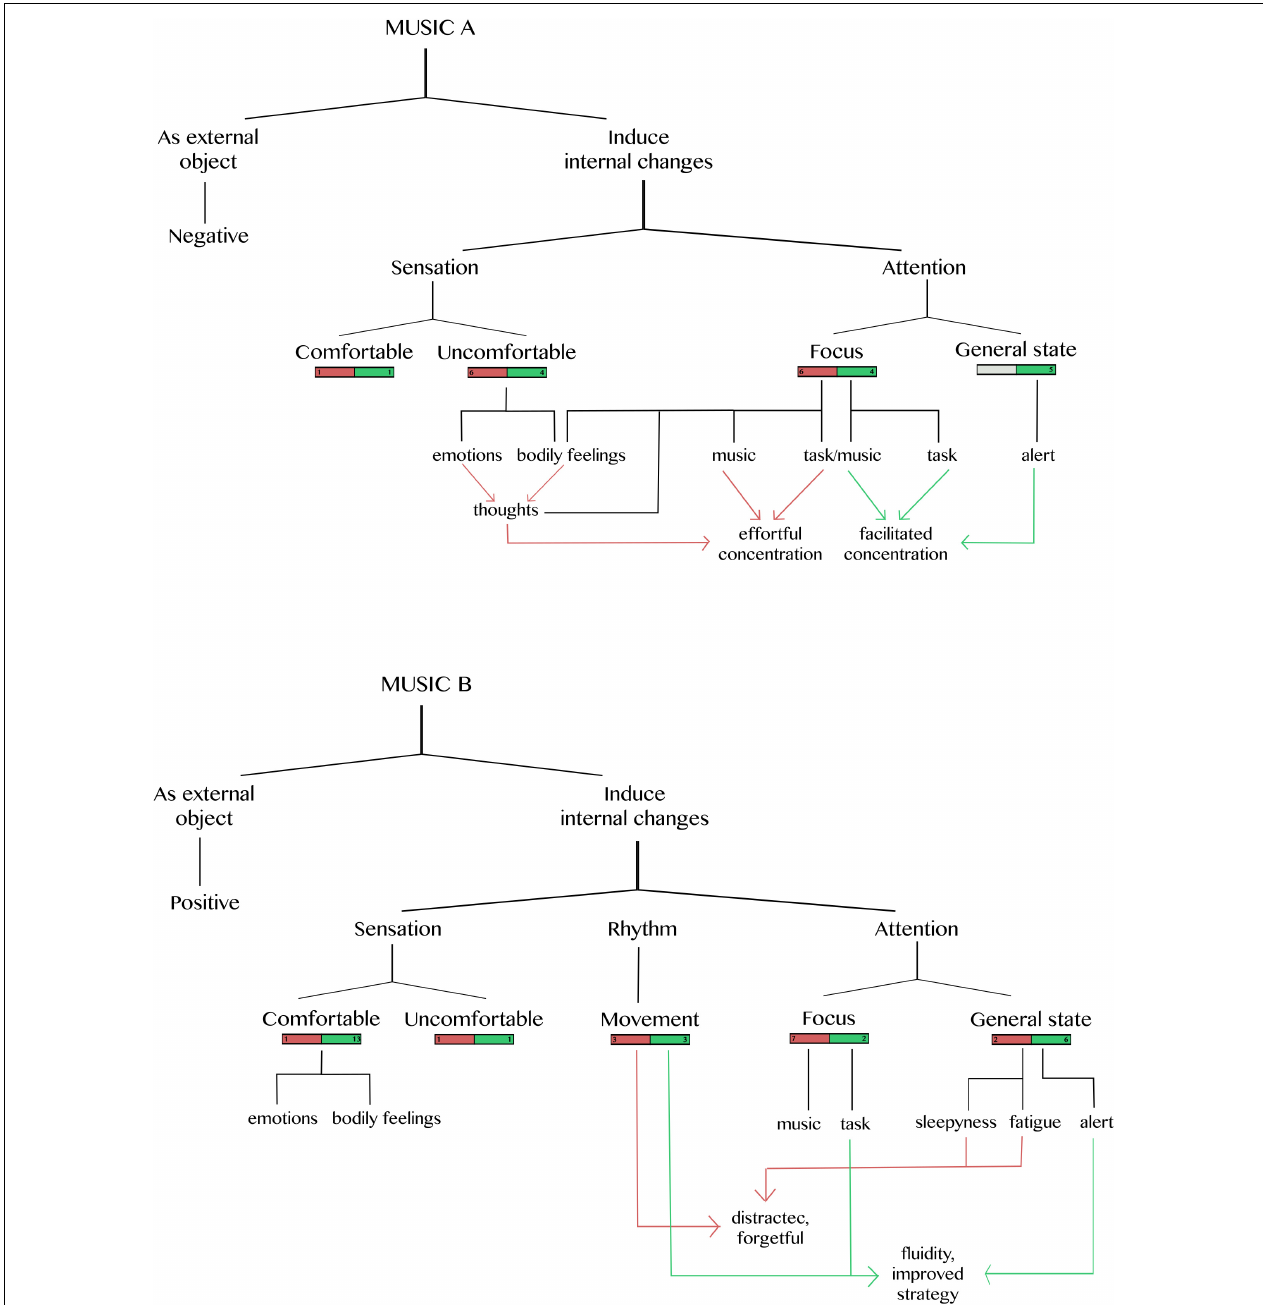
FIGURE 5 | Representative scheme of the generic structure of the experience of performing the task with background music. Experiential categories that emerged from the experience are shown: squares in red show the number of participants who felt hindered during task execution; green squares show the number of participants who felt facilitated during task execution. Arrows relate the experiential categories and the level of on task concentration of the participants. Upper panel : music A; Lower panel : music